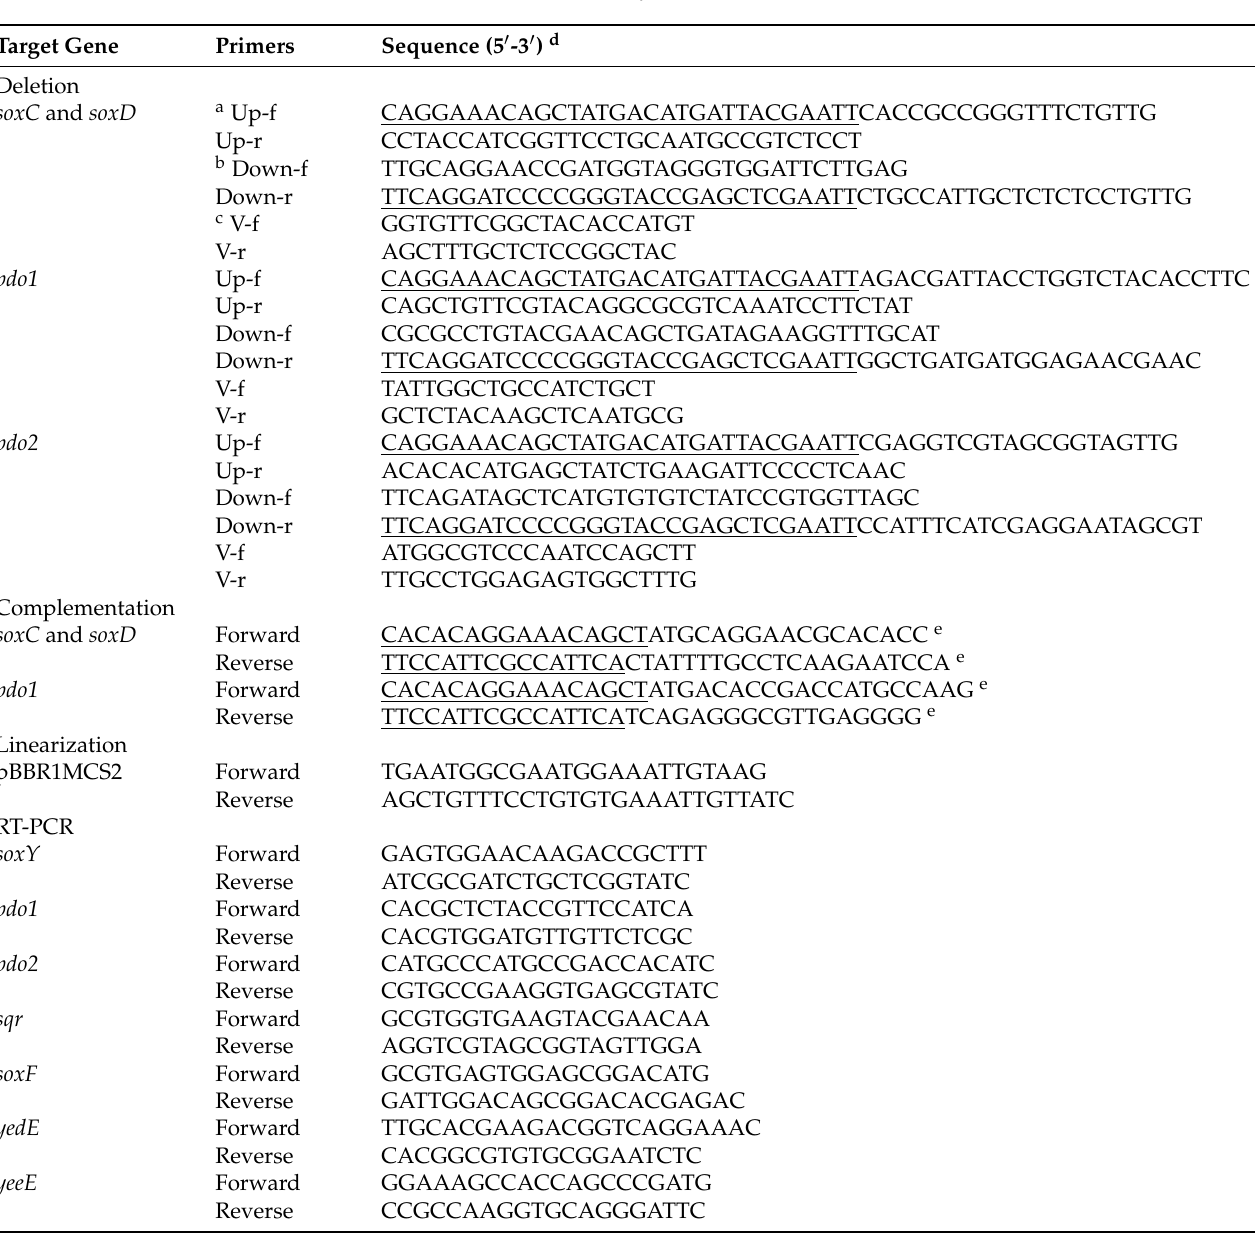
Table 2. Primers used in this